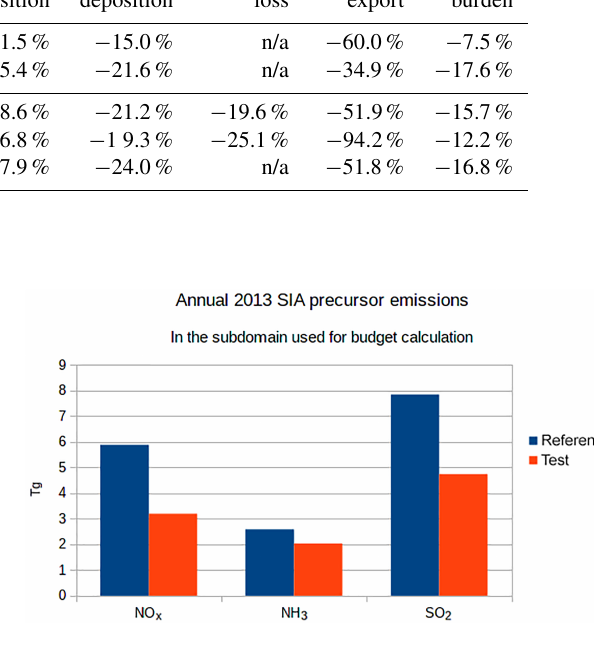
Figure 11. Annual emissions of SIA precursors, NO x , NH 3 and SO 2 for the year 2013 computed over the budget domain in the reference simulation in blue and the sensitivity test in